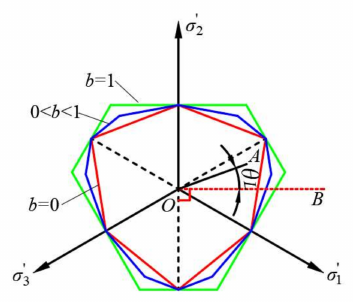
Figure 1. Unified strength theory limit surface on deviatoric